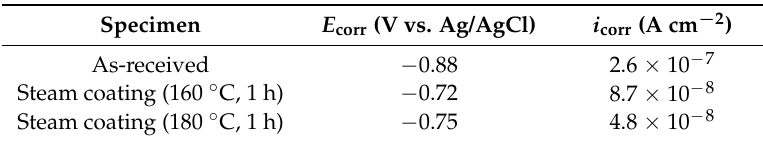
Table 2. Fitting results of potentiodynamic polarization curves of as-received and film-coated specimens immersed in NaCl solution.